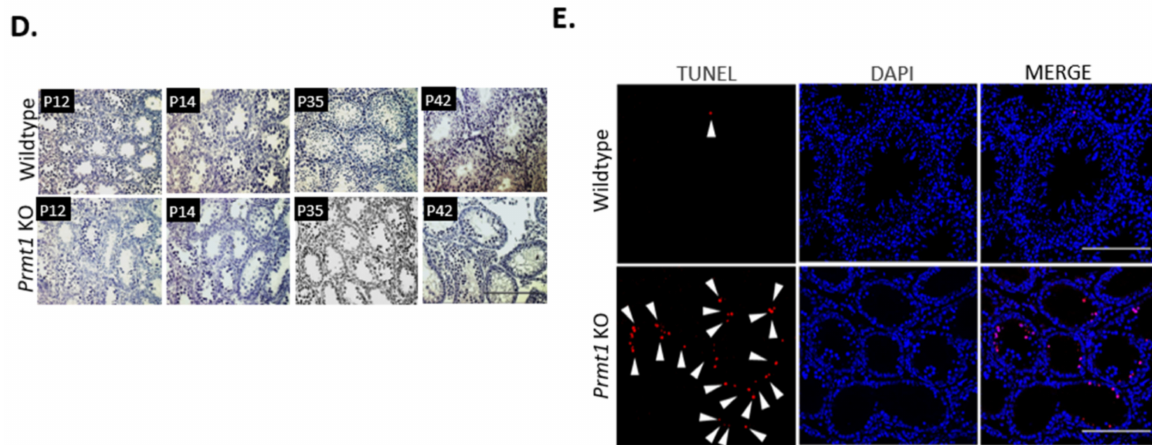
Figure 1. Deletion of the protein arginine methyltransferase 1 ( Prmt1 ) in mouse testes results in massive germ cell loss. ( A ) Detection of PRMT1 (pink) expression in wildtype testes on postnatal day 10 (P10), P12, and P35 by immunofluorescence. DNA was stained with 7 (cid:48) -amino actinomycin D (AAD) (blue). Scale bar, 50 µ m. ( B ) Confirmation of neurogenin 3 (Ngn3)- Cre-mediated germ cell-specific PRMT1 deletion at P10. PRMT1 (red) colocalized with 7 (cid:48) -AAD (blue). Scale bar, 50 µ m. ( C ) Morphological analysis of P10, P14, P30, P35, and P42 testes of the wildtype and Prmt1 KO mice. Differences in size start on P14, with approximately 70% reduction in the weight of the Prmt1 KO mouse testis compared with the weight of the control mouse testis. **** p < 0.0001. ( D ) Hematoxylin staining of wildtype and Prmt1 KO testes on P12, P14, and P35. Differences in types and number of germ cells start on P12, and become significantly prominent with an increase in the age of the mice. Most of the seminiferous tubules were atrophic in adult (P35 and P42) Prmt1 KO testes. Scale bar, 50 µ m. ( E ) Immunofluorescence results of the TUNEL (red) analysis of the wildtype and PRMT1 knockout testes on P35. The DNA was stained with DAPI (blue). White arrows indicate apoptotic cells. Scale bar, 50 µ